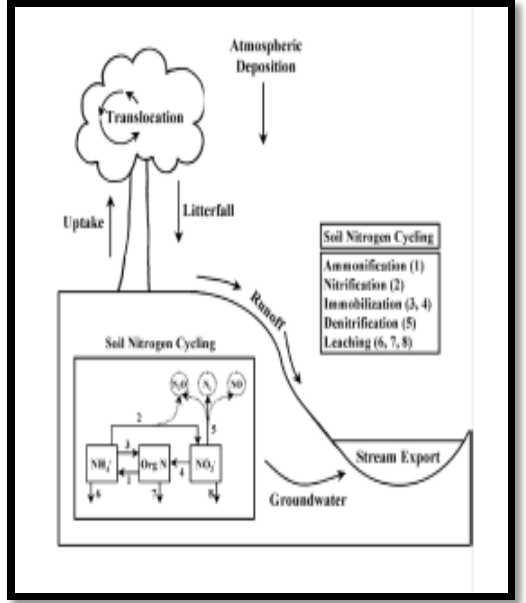
Fig 1. Diagrammatic representation of the major Components of the Nitrogen cycle Stable nitrogen and oxygen isotopes are useful in indicating sources when nitrate is present in surface or groundwater. Delta nitrate-nitrogen (δ15Nnitrate) and nitrate-oxygen (δ18Onitrate) isotope ratios in water can be used to identify nitrate sources and its fate in shallow groundwater. Nitrogen has two stable isotopes: 14N, with a natural abundance of 99.63% and 15N, with a natural abundance of 0.37%. The wide difference in the isotopic abundance allows for the determination of distinctive